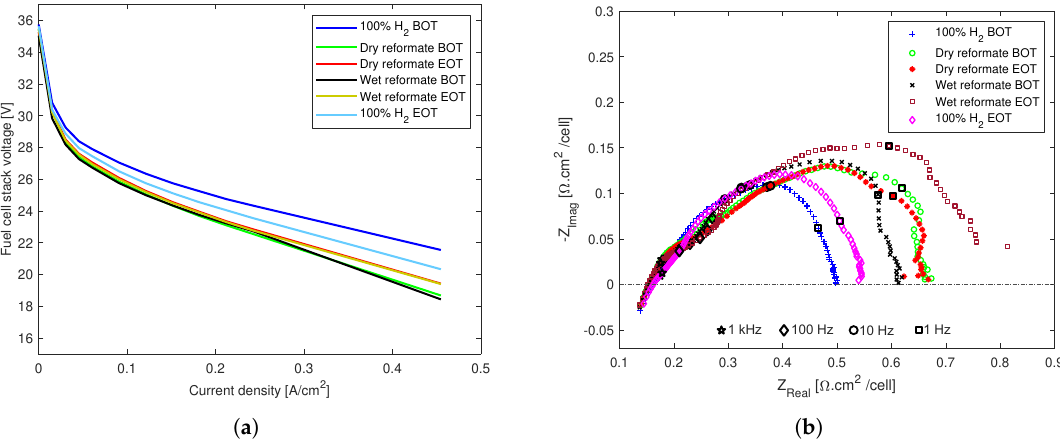
Figure 6. The effects of dry and wet reformate impurities on an HT-PEMFC stack with an MEA composed of a post-doped PBI membrane and non-woven GDL. ( a ) Polarization curves. ( b ) EIS